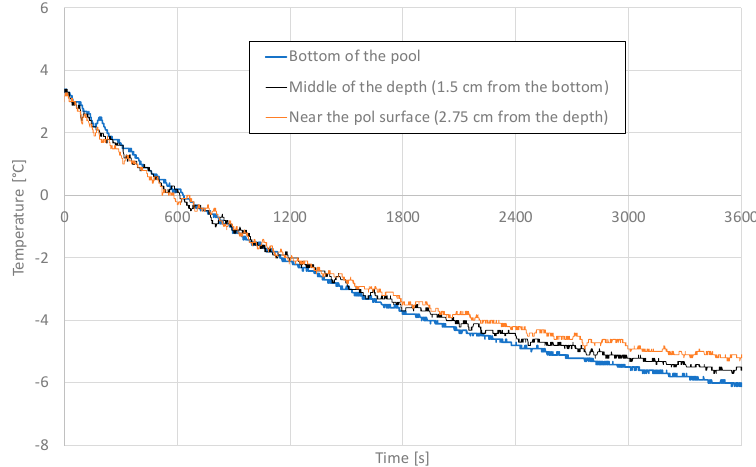
Figure 7. Temperature evolution at three depths for the small-scale reference case.